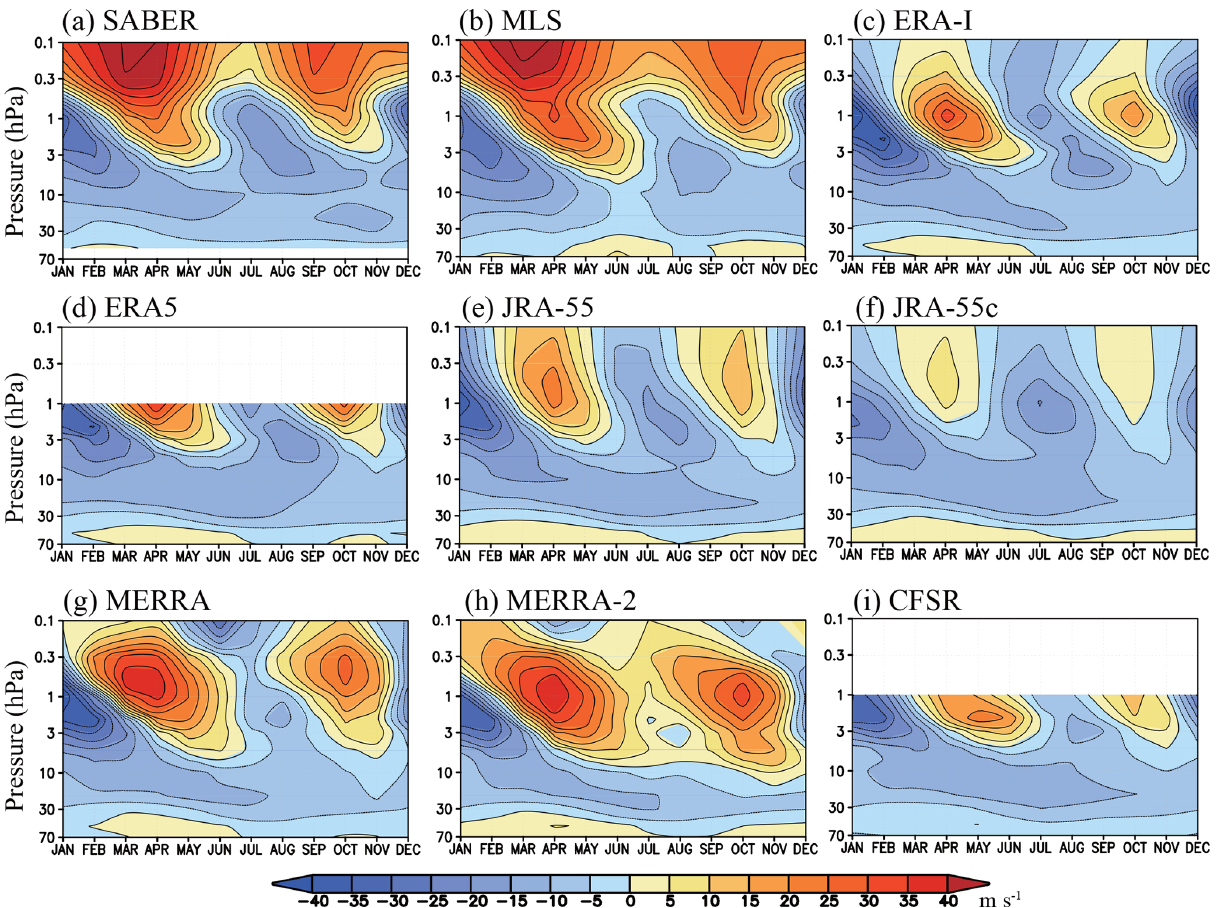
Figure 9. Time–height sections of climatological mean annual cycle of the zonal mean zonal wind over the Equator for (a) SABER, (b) MLS, and (c–i) each reanalysis. Climatology is calculated from 1980 to 2010 in the reanalyses, from 2002 to 2016 in SABER, and from 2005 to 2016 in MLS. The contour intervals are 5ms − 1